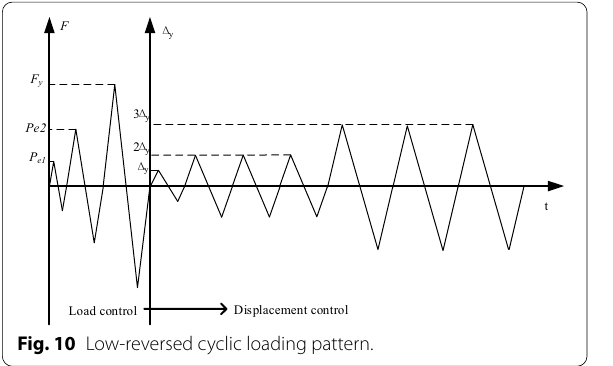
Fig. 10 Low-reversed cyclic loading pattern.